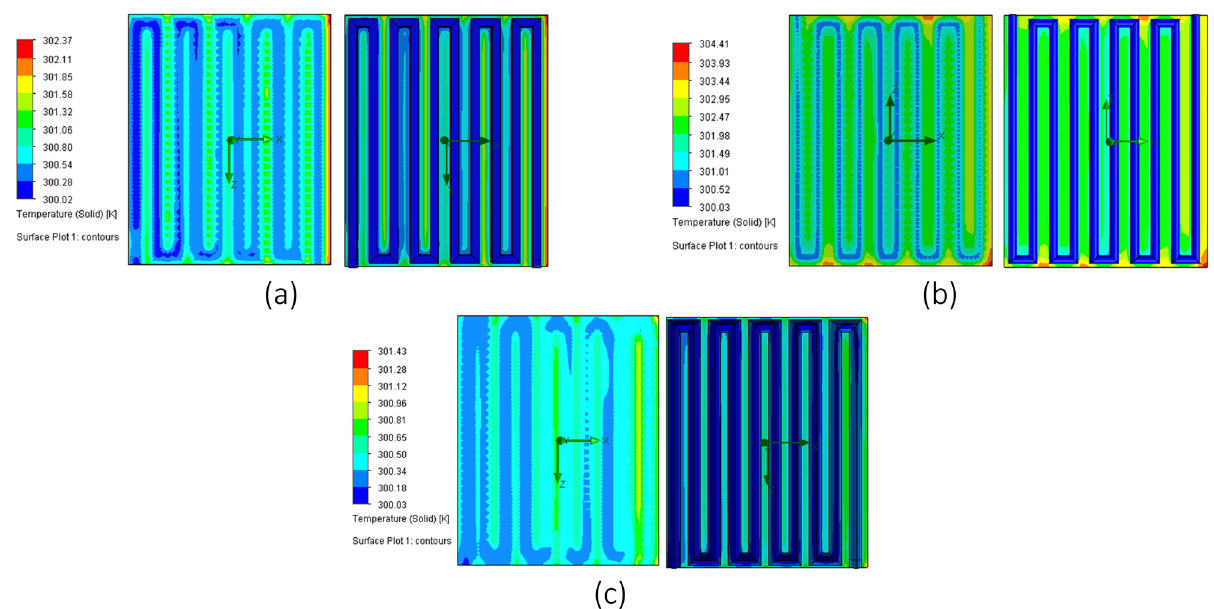
Figure 6: The contour of simulation results for solid temperature: ( a ) square box, ( b ) pipe box, and ( c ) triangle